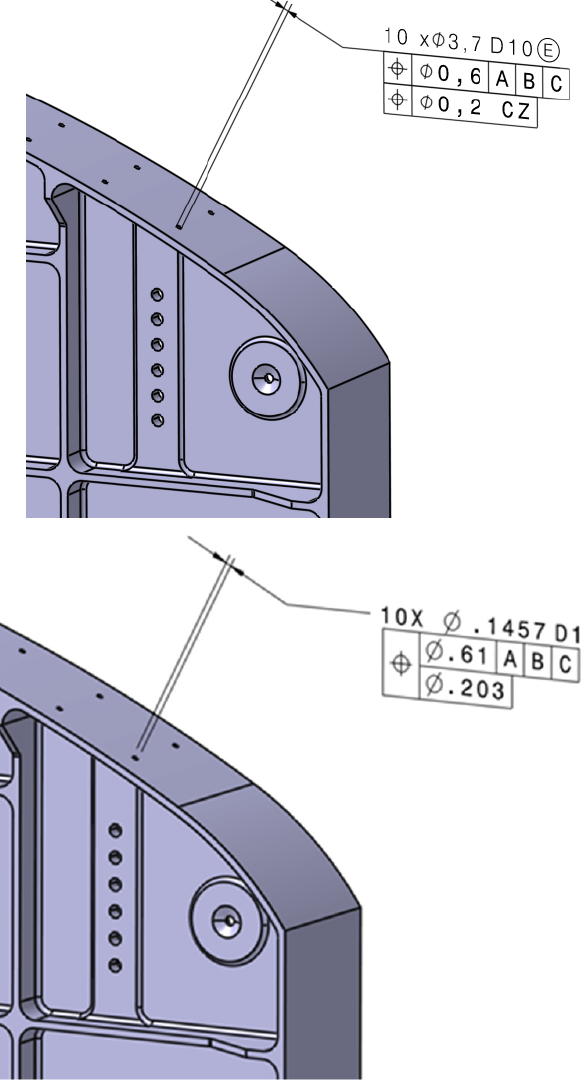
Figure A6. Flange holes in ISO model ( top illustration) and Flange holes in ASME model ( bottom illustration).